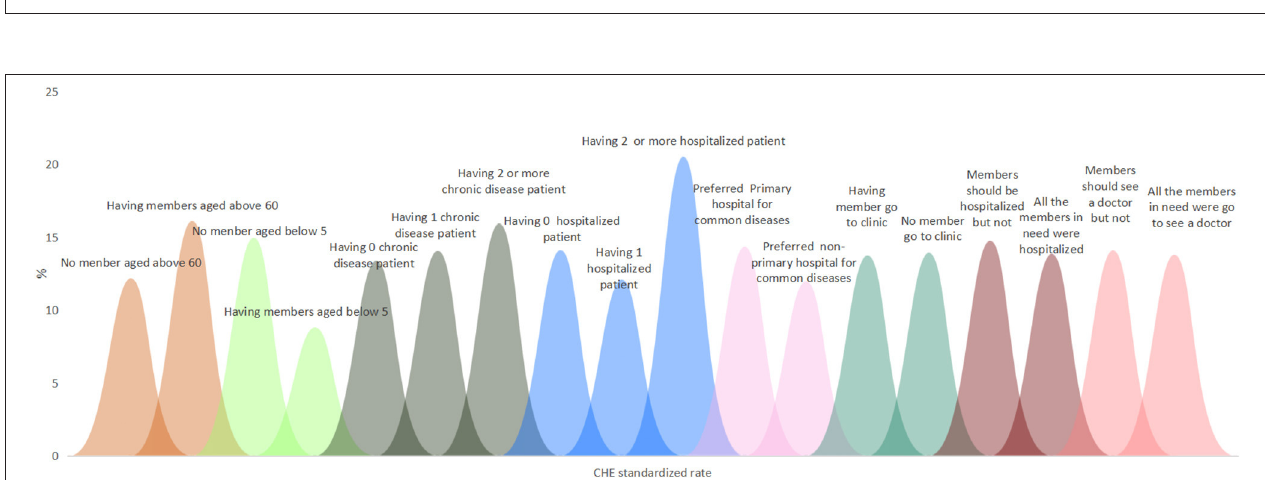
FIGURE 3 | The CHE standardized rate under the characteristics of single dimension related to demographic factors.